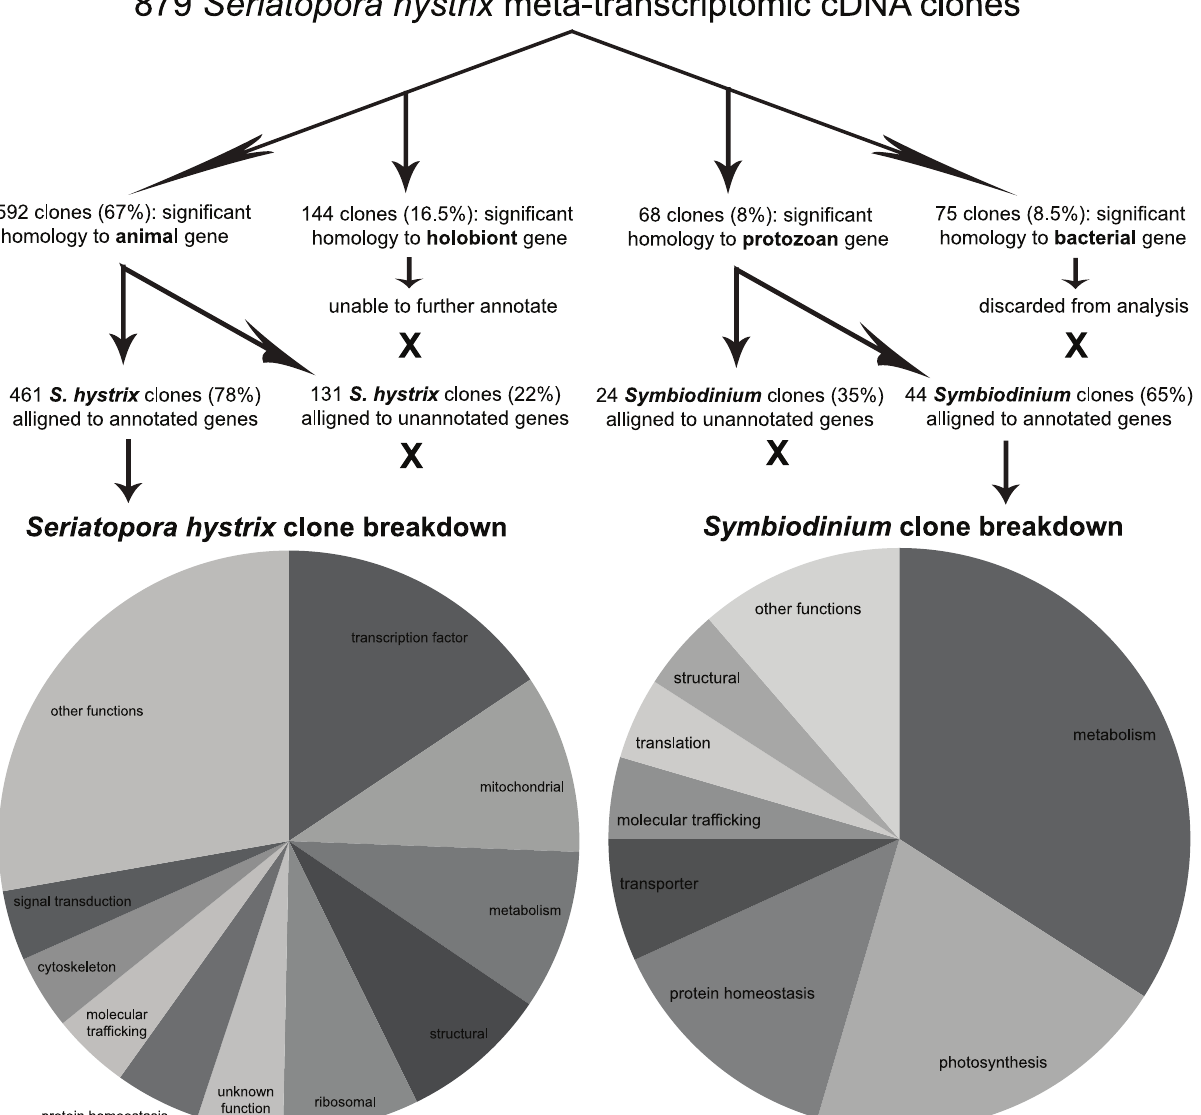
Figure 1. Schematic of cDNA library analysis and pie chart of results. A detailed list of select genes can be found in Table 1 ( Symbiodinium ) and Table S1